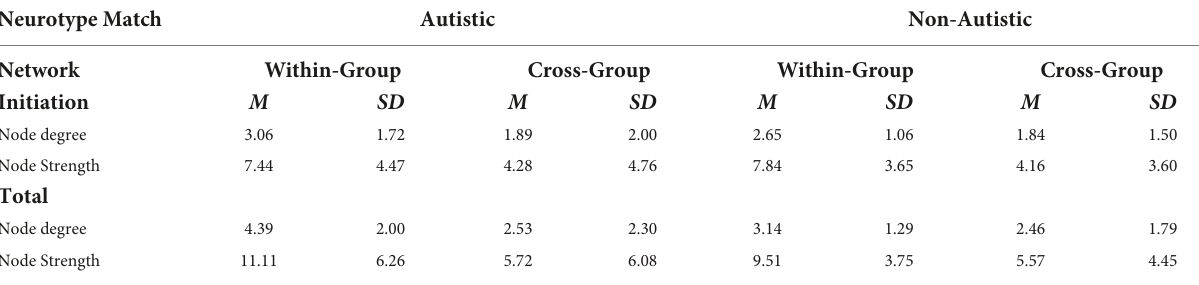
TABLE 2 Node degree and node strength by neurotype